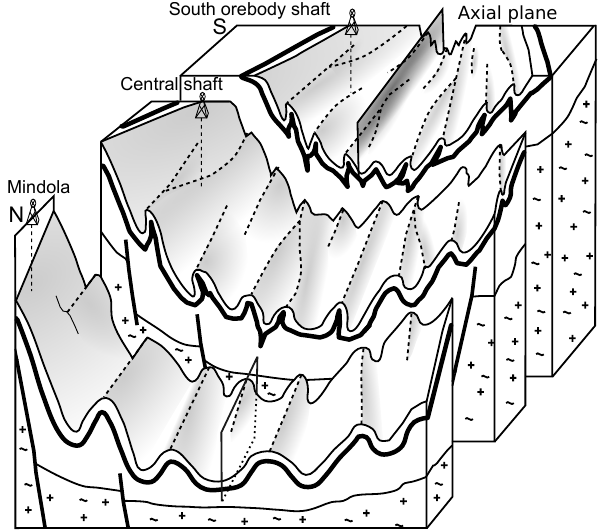
Figure 13. Interpretative schematic block diagram of the SE part of the Chambishi–Nkana Basin, showing first-order synclinal struc- ture plunging 20–30 ◦ to the NW. Only Lower Roan Group stratig- raphy is shown with the top of the Lower Roan Group exposed and the COM represented by the thick black line. Third-order folds are tight-to-isoclinally folded in the South generally opening up to- wards the north. The COM at South Orebody behaves in a ductile way and is pinched out or fault-bounded in the fold hinges, and folds sometimes plunge southwards. Towards the north, the lithofa- cies of the COM changes to a more competent unit with the Mindola and Mindola North shafts excavating the north-eastern limb of the second-order